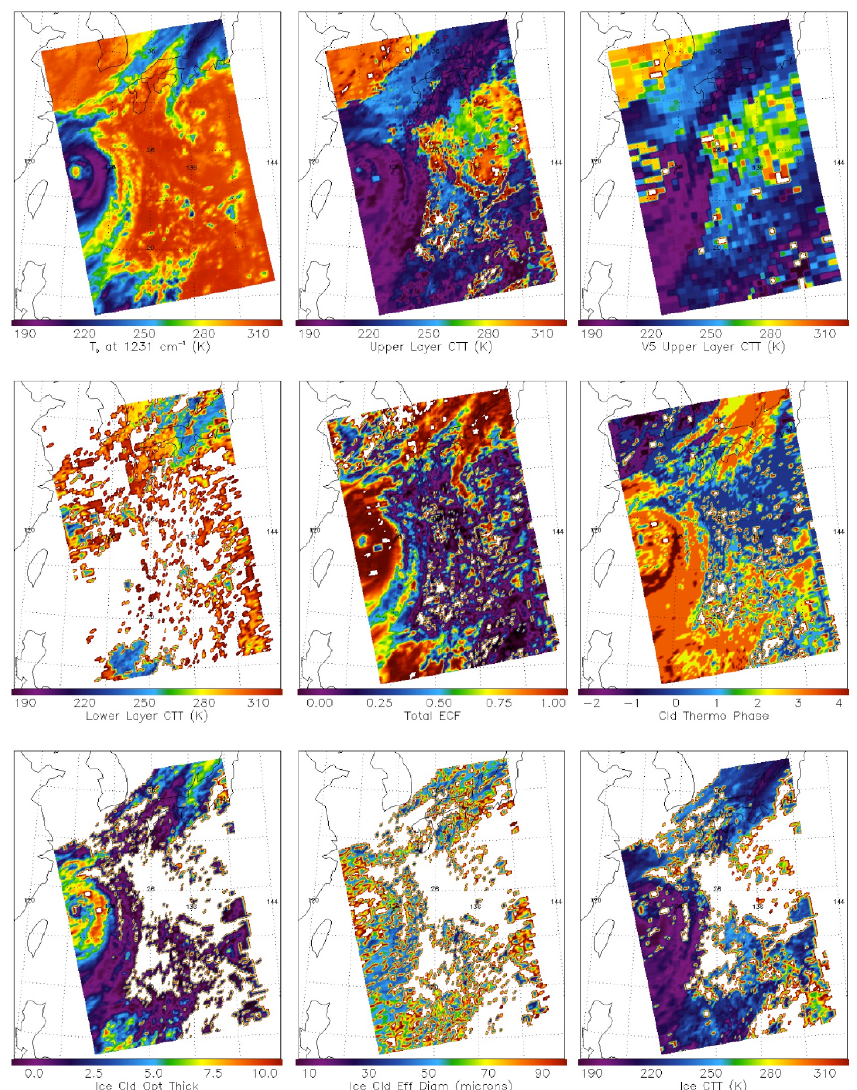
Fig. 1. Granule maps from 6 September 2002. Upper row (left to right) is the T b , 1231 (K), the v6 upper-layer T C , and the v5 upper-layer T C . Middle row (left to right) is the v6 lower-layer T C , the v6 total ECF, and the v6 cloud thermodynamic phase. Lower row (left to right) is the ice cloud optical thickness τ , ice cloud effective diameter D e (µm), and ice cloud top temperature T C , ICE (K). The granule number is 044 with a start (end) time of 04:23:26 (04:29:26)